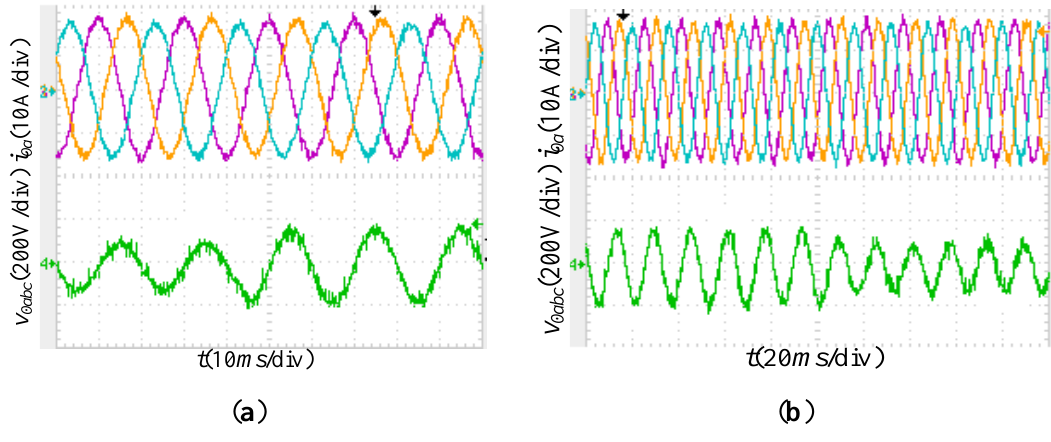
Figure 13. ( a ) Experimental results from grid-connected to islanding modes; ( b ) Experimental results from islanded to grid-connected modes.